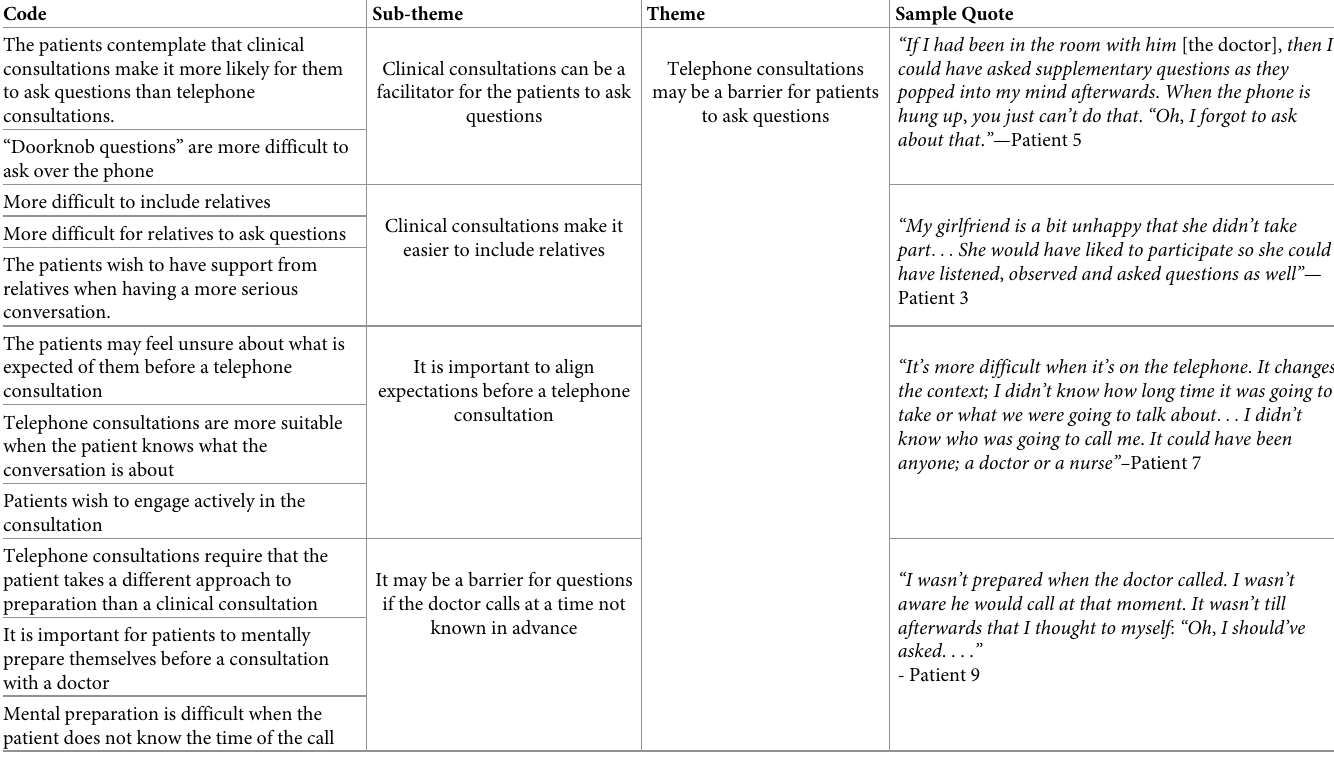
Table 5. Examples from the qualitative content analysis; from code to theme.